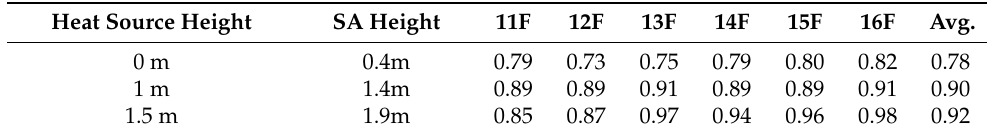
Table 11. PMV values with various heat source heights.